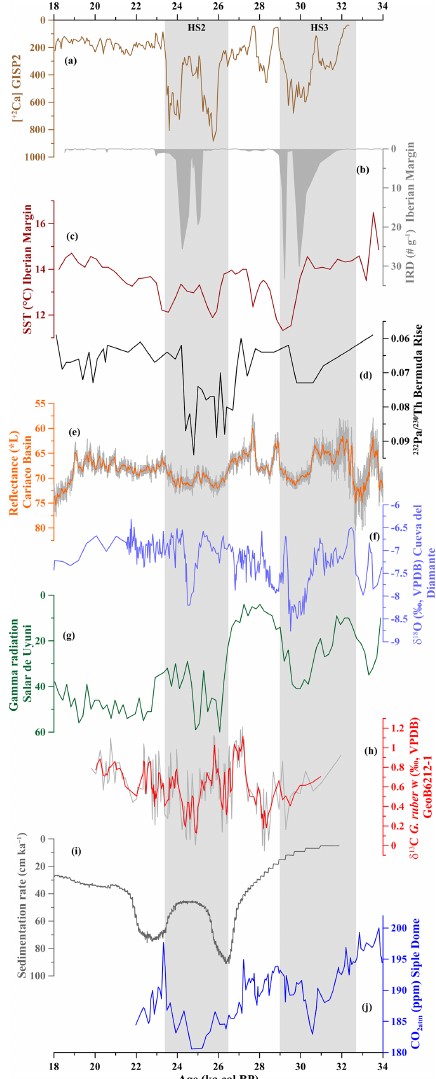
Figure 5. Proxy records from the western South Atlantic, western and eastern North Atlantic, and tropical South America, spanning Heinrich Stadial 3 (HS3) and Heinrich Stadial 2 (HS2) (Goni and Harrison, 2010; Sarnthein et al., 2001). (a) Changes in atmospheric circulation over Greenland derived from Greenland Ice Sheet Project 2 (GISP2) Ca + 2 concentration (Mayewski et al., 1997) plotted versus the Greenland Ice Core Chronology 2005 (GICC05) (Andersen et al., 2006; Rasmussen et al., 2006) at 72.6 ◦ N, 38.5 ◦ W. (b) Heinrich layers indicated by the presence of ice-rafted debris (IRD) from the Iberian Margin marine sediment core MD99-2331 at 42.2 ◦ N, 9.7 ◦ W (Eynaud et al., 2009). (c) Sea surface temperature (SST, ◦ C) changes from Iberian Margin marine sediment cores SU8118 and MD952042 at 37.5 ◦ N, 10.1 ◦ W (Bard, 2000). (d) Atlantic meridional overturning circulation (AMOC) strength derived from Bermuda Rise sedimentary 231 Pa / 230 Th ratio from ODP site 1063 (higher values indicate a reduced AMOC) at 33.7 ◦ N, 57.6 ◦ W (Lippold et al., 2009). (e) Position of the Intertropical Convergence Zone (ITCZ) indicated by reflectance (*L) (higher values indicate decreased precipitation) from the Cariaco Basin marine sediment core MD03-2621 at 10.7 ◦ N, 65 ◦ W (Deplazes et al., 2013) (orange line represents a 399-point running average). (f) Strength of western Amazon precipitation indicated by the δ 18 O from stalagmite NAR-C collected in the Cueva del Diamante Cave, western Amazon (more negative values indicate increased precipitation), at 5.4 ◦ S, 77.3 ◦ W (Cheng et al., 2013). (g) Presence of palaeolakes indicated by the natural gamma radiation from Bolivian Altiplano Salar de Uyuni (higher values indicate increased precipitation) at 20.3 ◦ S, 67.5 ◦ W (Baker et al., 2001). (h) Globigerinoides ruber white ( G. ruber w) δ 13 C from marine sediment core GeoB6212-1 collected in the western South Atlantic at 32.4 ◦ S, 50.1 ◦ W (red line represents a three-point running average, this study). (i) Sedimentation rates from marine sediment core GeoB6212-1 collected in the western South Atlantic at 32.4 ◦ S, 50.1 ◦ W (this study). (j) Atmospheric CO 2 concentration (ppm) from ice core Siple Dome (Ahn and Brook, 2014) plotted versus the Greenland Ice Core Chronology 2005 (GICC05) (Svensson et al., 2008) at 81.7 ◦ S, 148.8 ◦